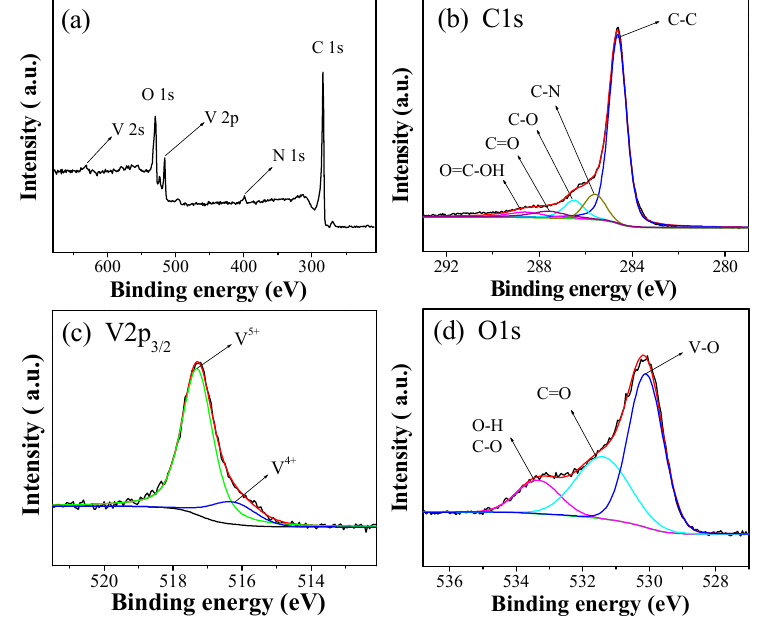
Figure 5. X-ray photoelectron spectroscopy (XPS) survey spectra ( a ); C1s ( b ); V2p 3 / 2 ( c ) and O1s ( d ) of Figure 5. X ‐ ray photoelectron spectroscopy (XPS) survey spectra ( a ); C1s ( b ); V2p 3/2 ( c ) and O1s ( d ) of the VG-N-A300 the VG ‐ N ‐ A300 composites.